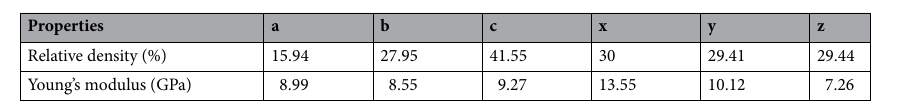
Table 2. Relative densities and the corresponding Young’s moduli of MGSs in Group 1 and Group 2.